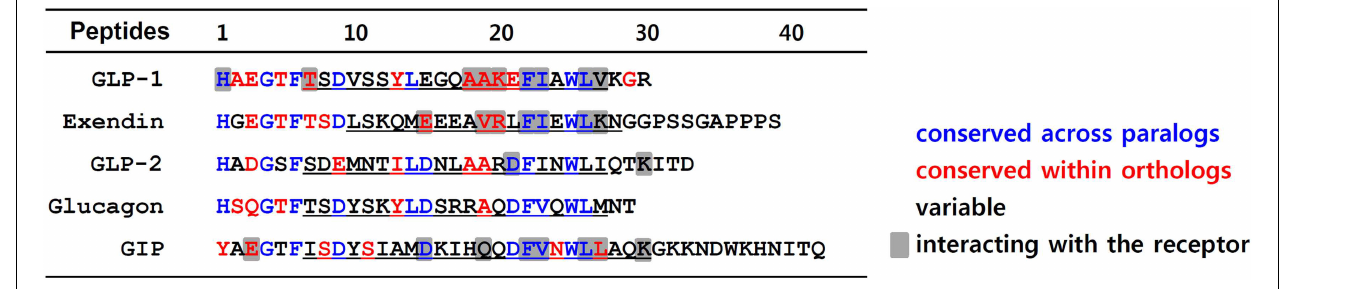
FIGURE 1 |Amino acid sequence alignment of GLP-1 and its family peptides. Amino acid sequences of human GLP-1, GLP-2, glucagon, GIP, and Gila monster exendin are aligned. Residues in red are conserved sequences within orthologs of vertebrates including mouse, anole, chicken, Xenopus tropicalis , medaka, fugu, tetraodon,